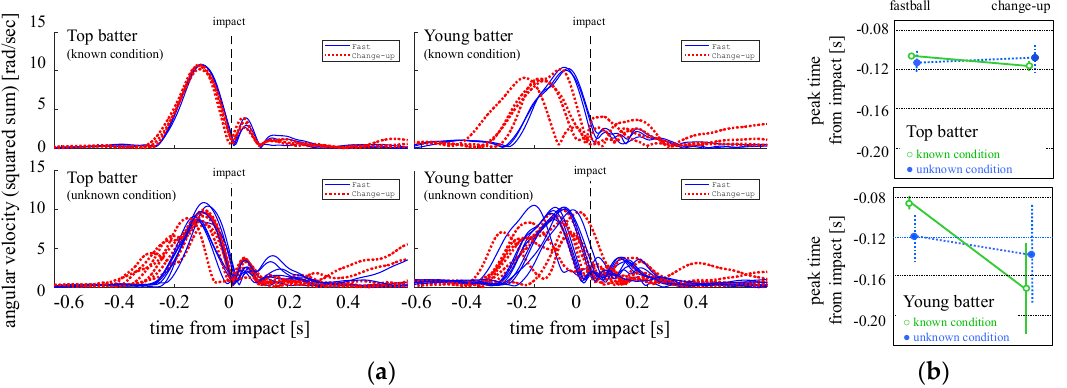
Figure 3. ( a ) Trajectories of the squared sum of angular velocity components of pelvis aligned at impact time (upper left: top batter (known), upper right: young batter (known), lower left: top batter (unknown), lower right: young batter (unknown)); ( b ) Peak time of pelvis angular velocity of a top batter and a young batter (upper left: top batter (fastball), upper right: top batter (change-up), lower left: young batter (fastball), lower right: young batter (change-up), green: known, blue: